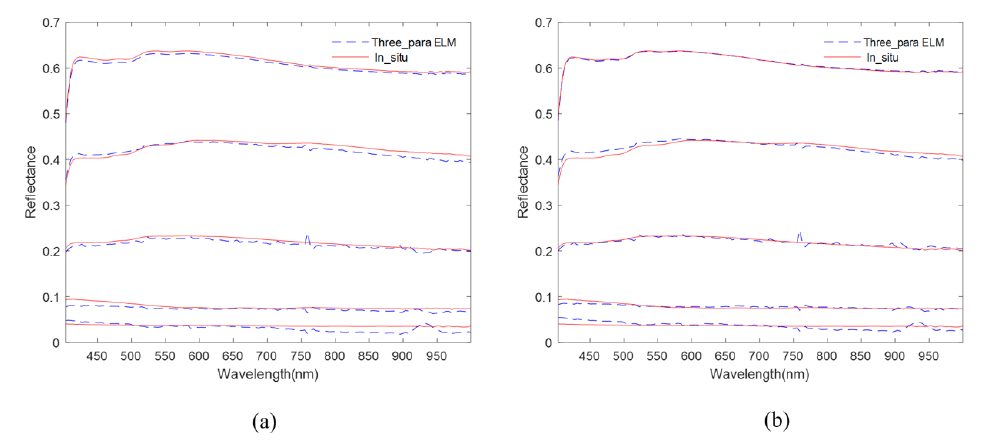
Figure 8. Comparison of the reflectance results of multi-gray level calibration target retrieved by three-parameter empirical method with in suit measurement results: ( a ) Three parameter empirical method; and ( b ) three parameter empirical method of adding illumination correction.